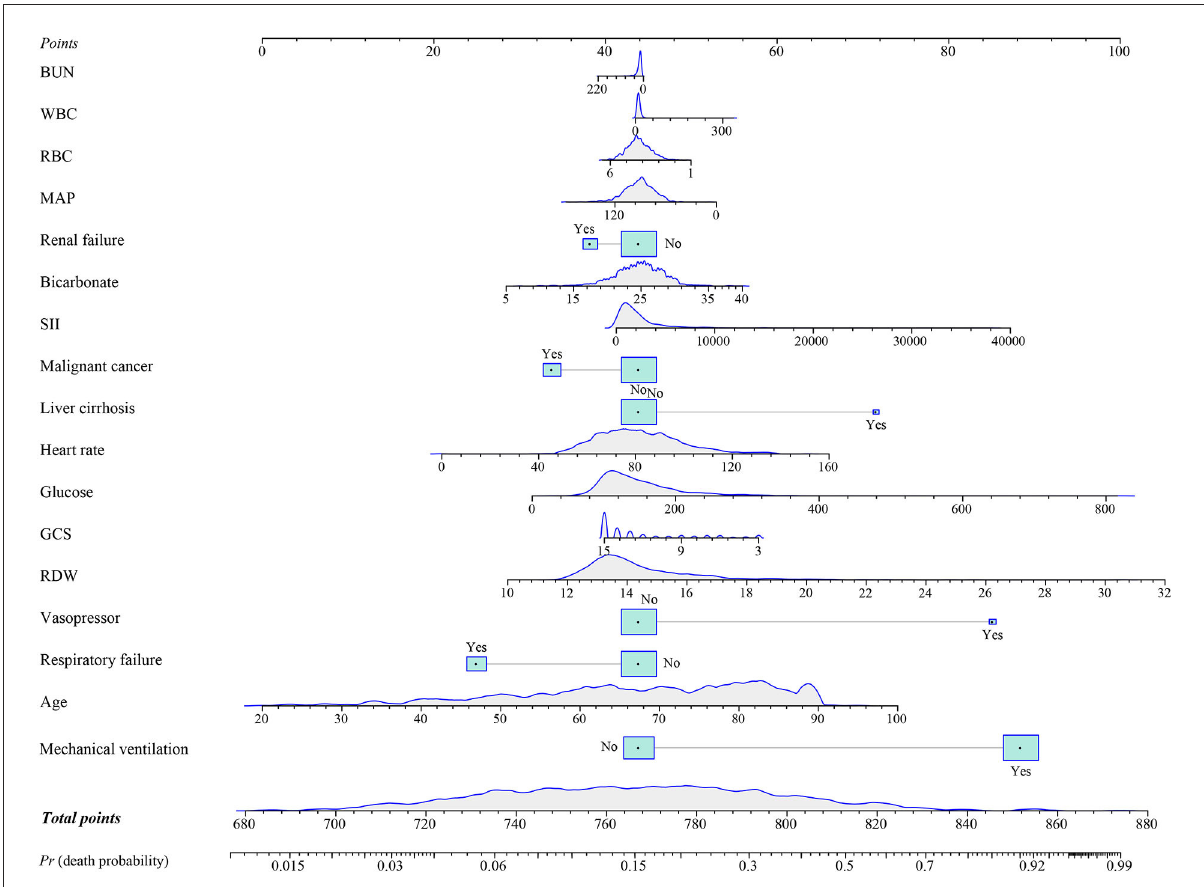
FIGURE3 A nomogram to predict the risk of in-hospital death for patients with intracerebral hemorrhage (ICH). BUN, blood urea nitrogen; WBC, white blood cell count; RBC, red blood cell; MAP, mean artery pressure; SII, systemic immune-inflammation; GCS, Glasgow Coma Scale; and RDW, red blood cell distribution